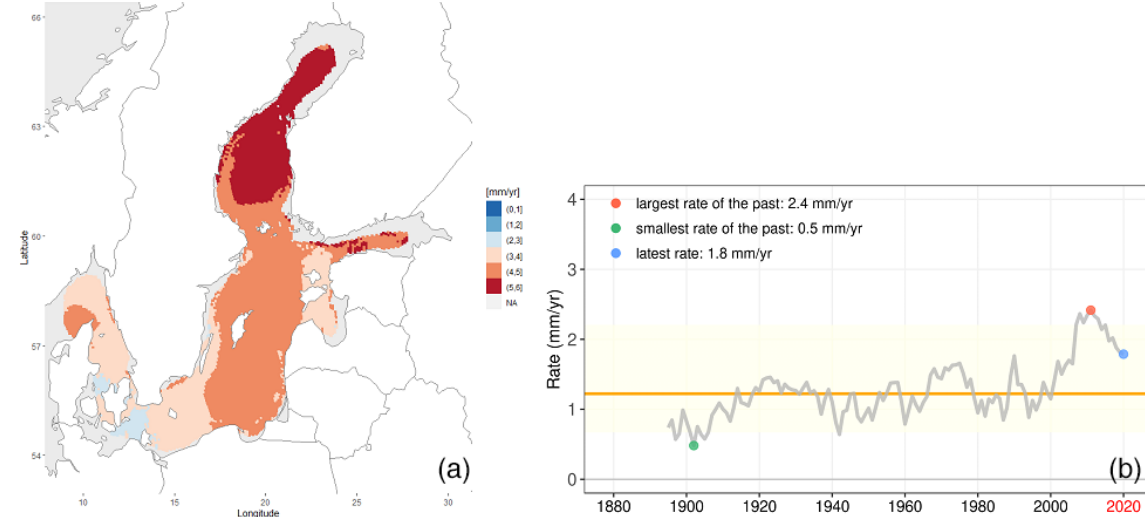
Figure 5. (a) Trends in annual absolute mean sea level from 1995 to 2019 derived from multi-mission satellite altimetry (redrawn and modified from Passaro et al., 2021.). Trends were provided by Baltic SEAL (https://balticseal.eu, last access: 13 August 2021). Data and methods are described in Passaro et al. (2021). (b) Time series of relative sea level trends in Warnemünde over successive 40-year periods (redrawn and modified from https://sealevel-monitor.eu/, last access: 13 August 2021): the trend in 2020 is representative of 1981–2020, the trend in 1980 is representative of 1941–1980, and so on. The orange line represents the median, and the yellow area is the 5%–95% range of all 40-year trends. Note that the vertical land movement at Warnemünde is close to zero (0 . 55 ± 0 . 59mmyr − 1 ; estimate provided by https://www.sonel.org, last access: 28 June 2021, for the last about 11 years).